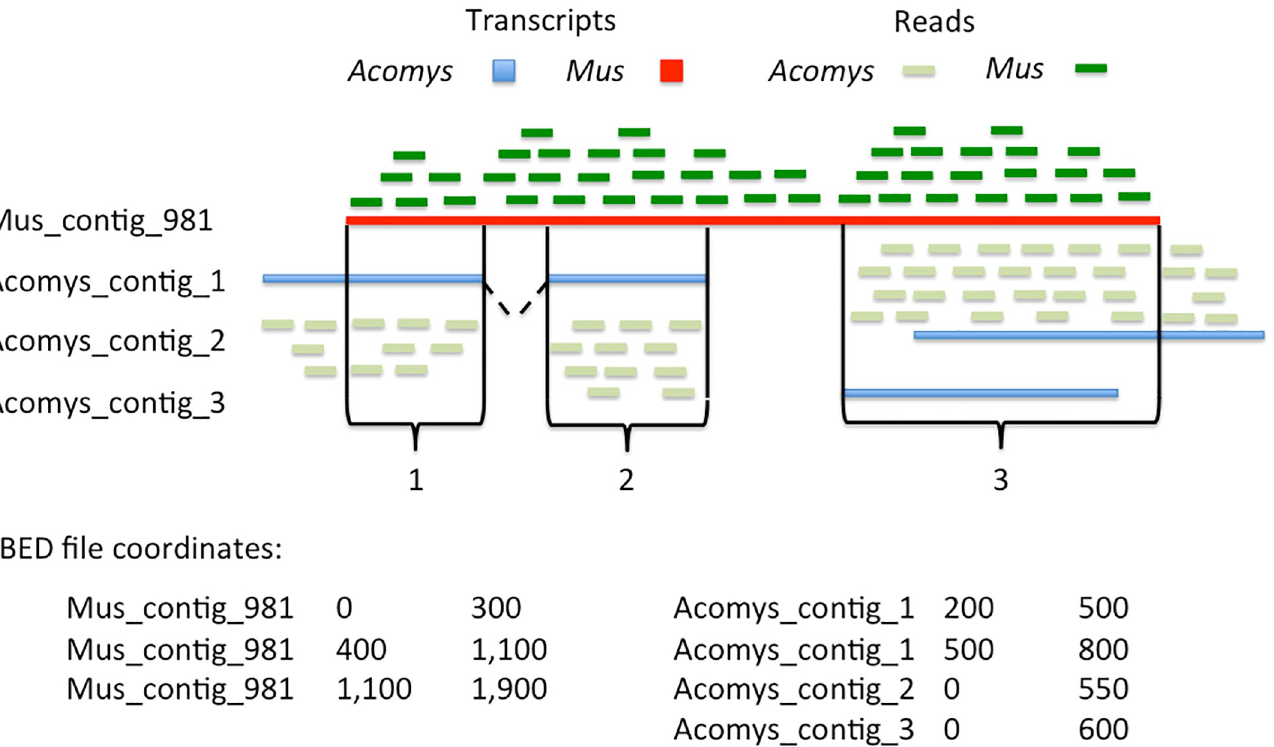
Fig 1. BED file generation and filtering using COREs between transcripts. Putative orthologs identified using a reciprocal best-hit approach are associated via HSPs. HSPs between orthologs are isolated from all hits for reciprocated isoforms allowing the generation of BED files in which coordinates correspond to their species-specific coordinates from the HSP. Multiple de novo isoforms from A . cahirinus are allowed to hit a single M . musculus transcript. M . musculus BAM files are filtered using the M . musculus -specific coordinates, and A . cahirinus BAM files are similarly filtered.